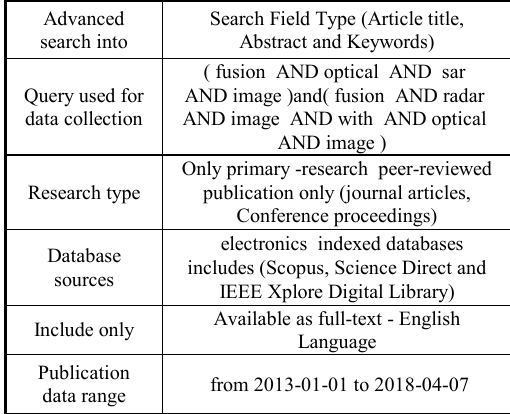
Table 2: Research standards